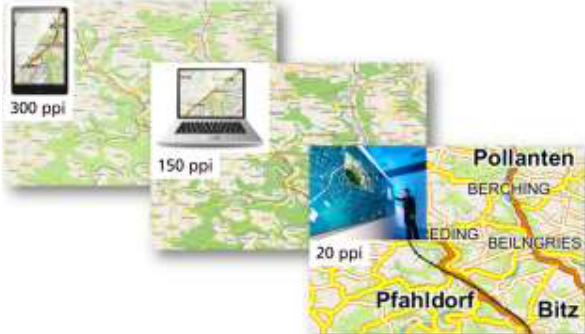
Figure 5: Adaptation of the display to the hardware resolution with the same spatial extent.